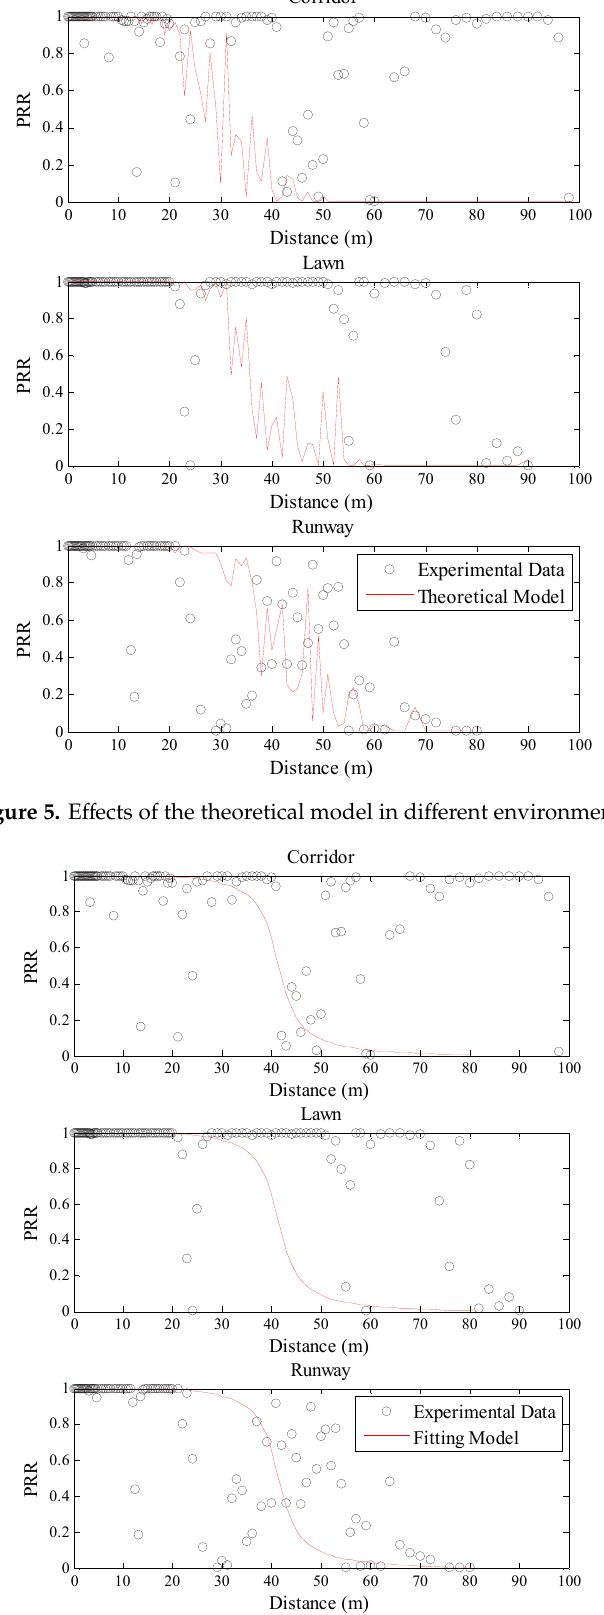
Figure 6. E ff ects of the fitting model in di ff erent Figure 6. Effects of the fitting model in different environments.